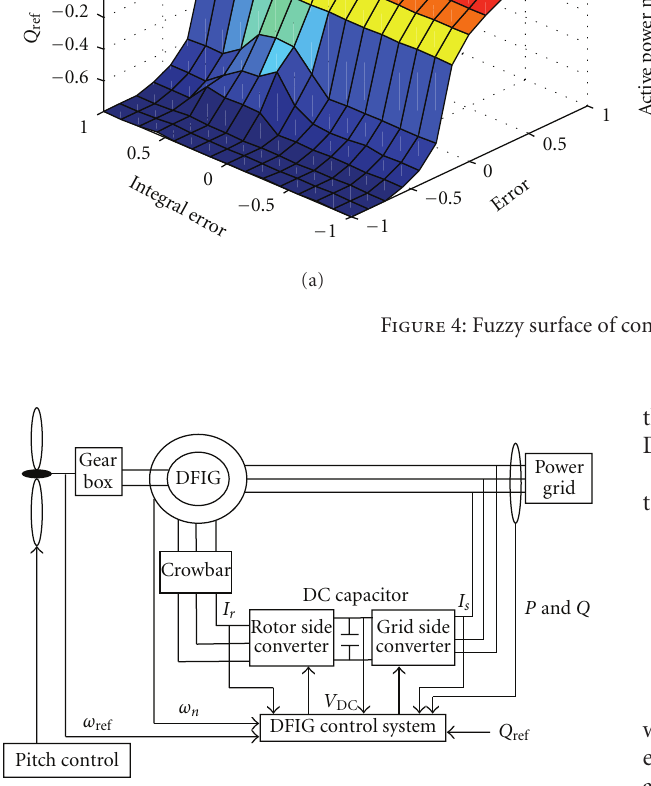
Figure 5: Configuration of DFIG-based WT connected to a